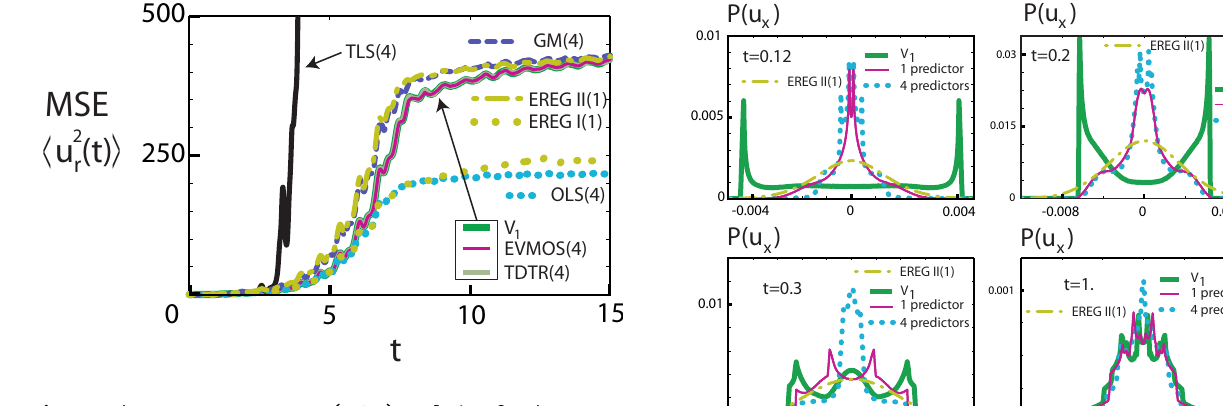
Fig. 5. The mean square error (MSE) evolution for the Lorenz model with large model error ( δr = 10 − 2 ) for long lead times and with 5 × 10 5 ensembles of 500 members.